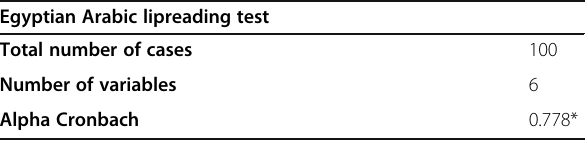
Table 8 The alpha Cronbach reliability analysis for the reliability of the used tool “ the Arabic lipreading test ”